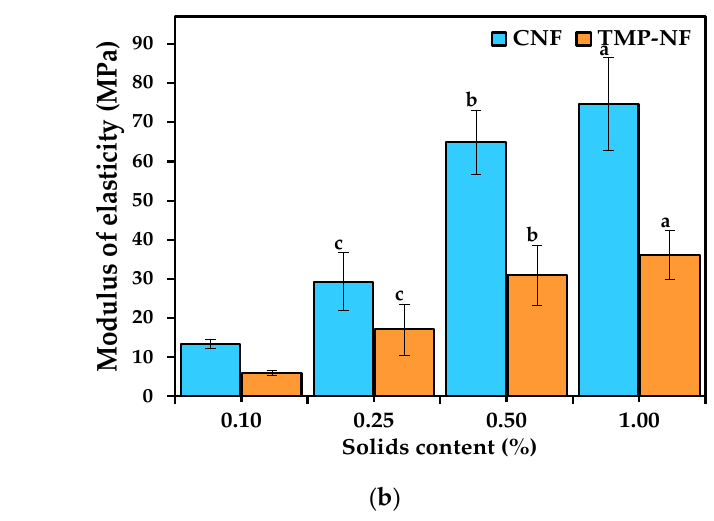
Figure 13. Mechanical analysis of the developed films. ( a ) Uniaxial tensile test; ( b ) Modulus of elasticity. Note: Values are presented as means ± SD. N = 6. Values followed by common letters in the super index indicate estimated significant differences between each pair of means media ( p > 0.05).